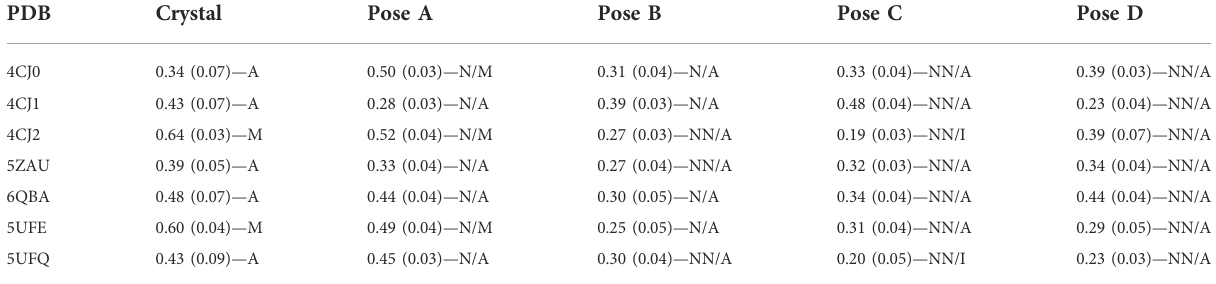
TABLE 3 DockQ values and quality of the models.